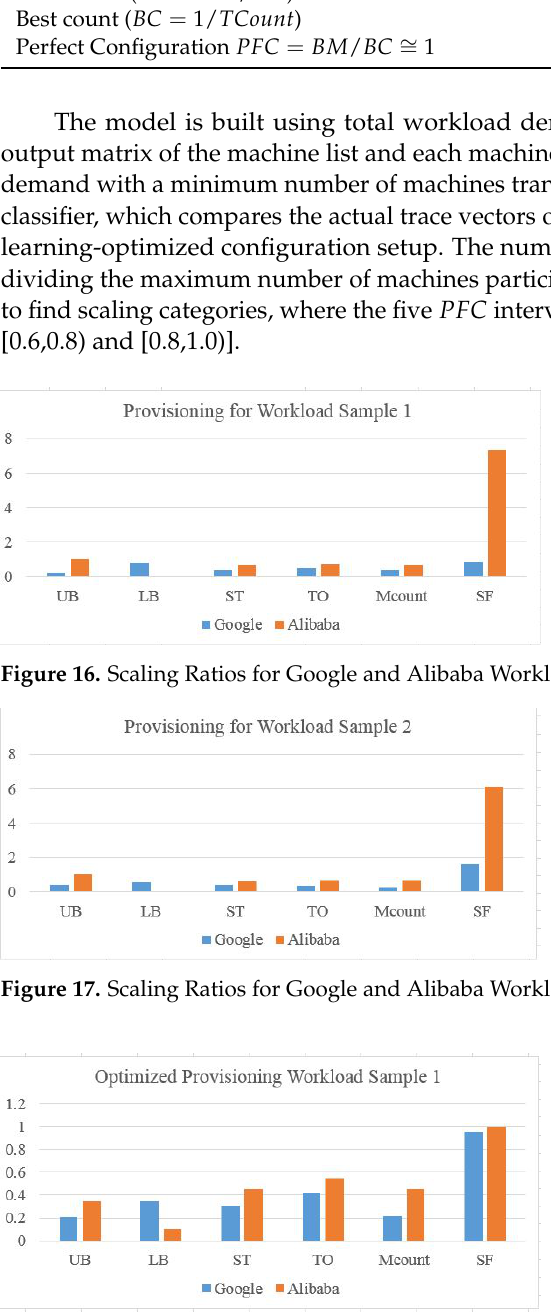
Figure 18. Optimized Scaling Ratios for Google and Alibaba Workload Type